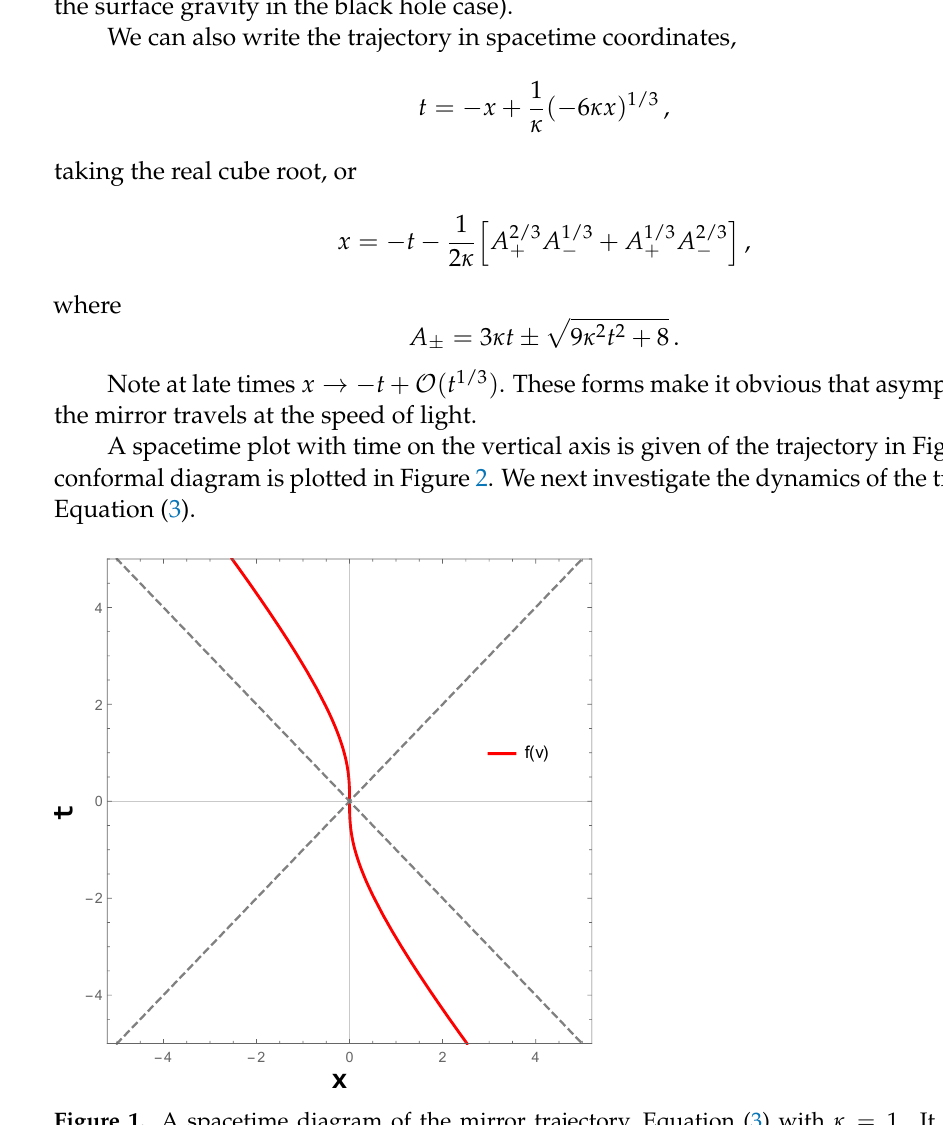
Figure 1. A spacetime diagram of the mirror trajectory, Equation (3) with κ = 1. It starts off asymptotically inertial with zero acceleration and light-speed velocity and decelerates, eventually reaching zero speed (at t = 0), and then accelerates again approaching the speed of light in an asymptotically inertial way. Note that field modes moving to the left will always hit the mirror, demonstrating no horizon, despite the mirror accelerating to